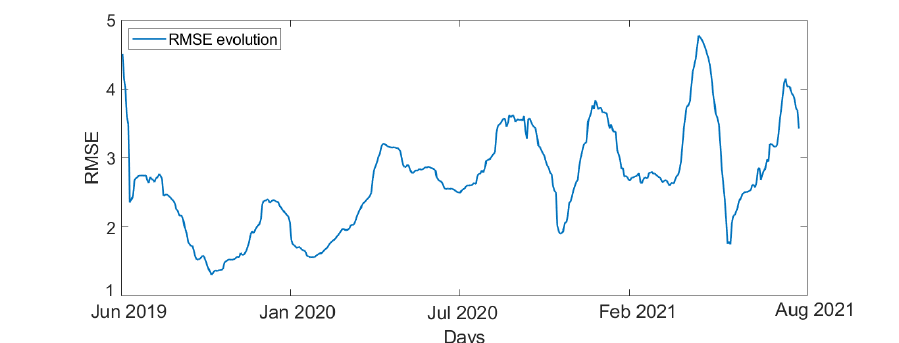
Figure 5. RMSE evolution calculated with a moving window over 20 days referring to the model’s prediction of the SO 2 flow rate that goes to the Claus